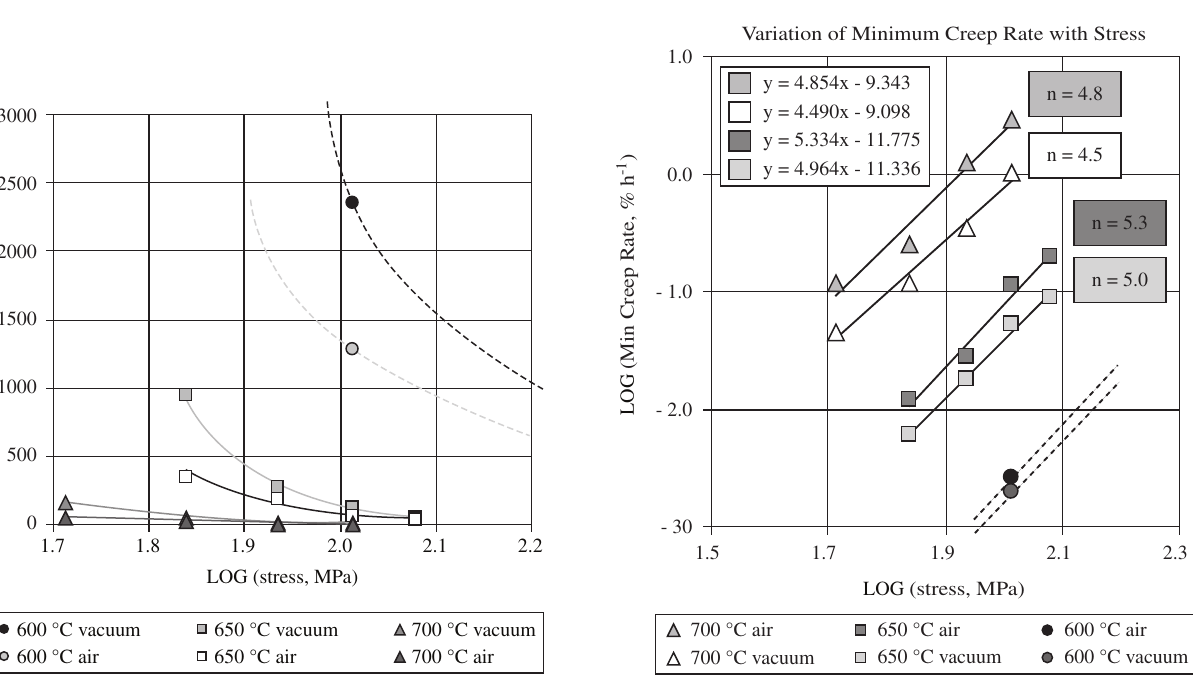
Figure 5. Variation of creep rupture time with stress, in air and in vacuum: for 700 °C and 650 °C, with schematic lines through the data at 600 °C.